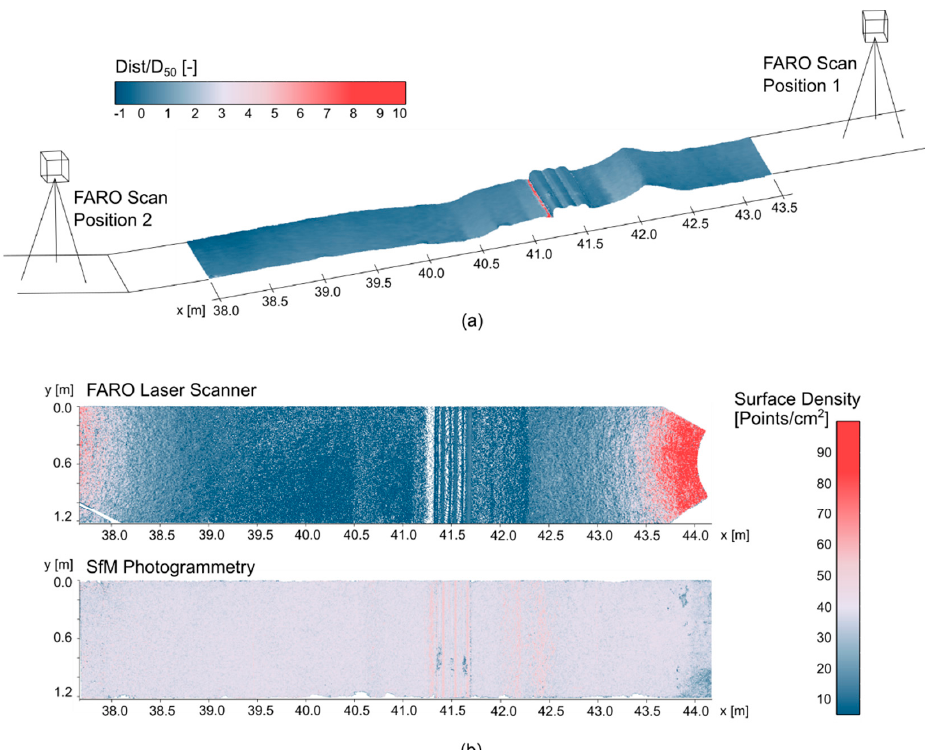
Figure 3. ( a ) Differences between point clouds obtained with the FARO laser scanner and ones ob- tained using the SfM photogrammetry for the example test considered (LWD29_v1,Triple, T p = 2.17 s, H s = 0.15 m) in relation to mean sediment diameter (Dist/D 50 ) and ( b ) surface densities (points/cm²) of points clouds obtained from FARO Laser Scanner and SfM photogrammetry.